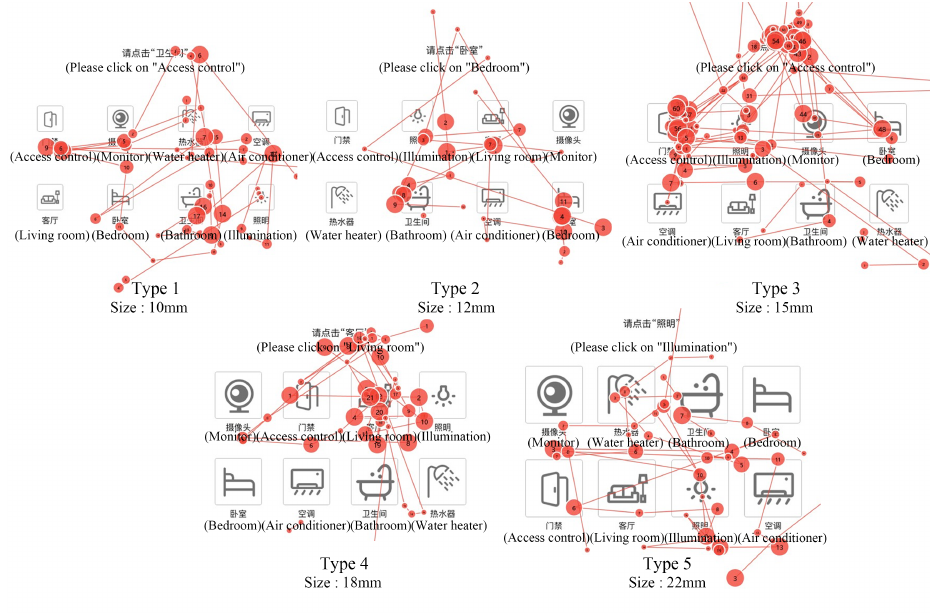
Figure 12. Eye movement saccade paths in the experimental interface of buttons of different